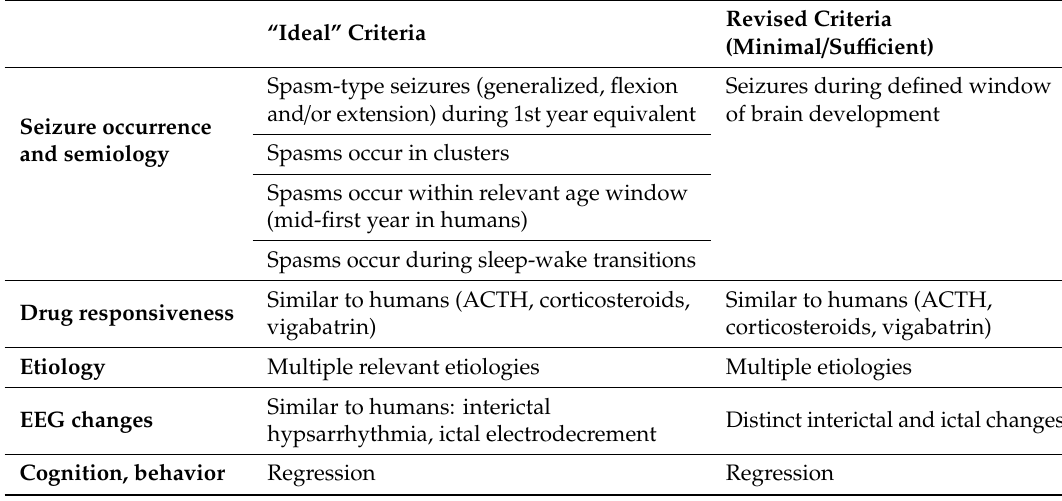
Table 1. Criteria for a Pre-clinical (Animal) Model of Infantile